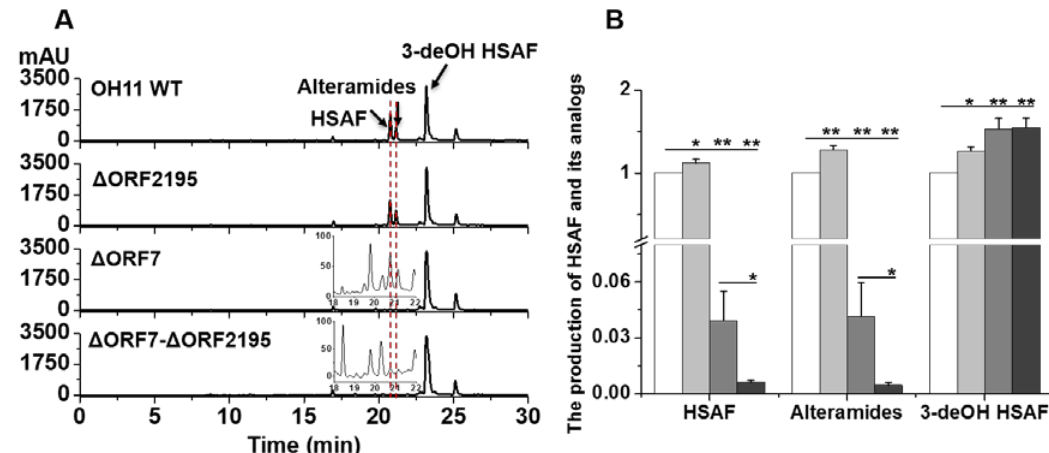
Figure 3. Production of HSAF and its analogs in deletion mutants of fatty acid hydroxylase genes in L. enzymogenes OH11. ( A ) HPLC analysis of HSAF and its analogs in strains WT, ∆ ORF2195, ∆ ORF7, and ∆ ORF7- ∆ ORF2195, cultured in 1 / 10 TSB medium for 48 h. ( B ) Quantification of HSAF and its analogs in these strains. White columns, WT; light-gray columns, ∆ ORF2195; medium-gray columns, ∆ ORF7; dark-grey columns, ∆ ORF7- ∆ ORF2195. Note: As the 3-deOH alteramides were minor compounds and not well-resolved from 3-deOH HSAF in HPLC, only 3-deOH HSAF was presented in the quantification. Data are presented as the averages of the three independent experiments, each conducted in triplicates, with * p < 0.05; ** p < 0.01.